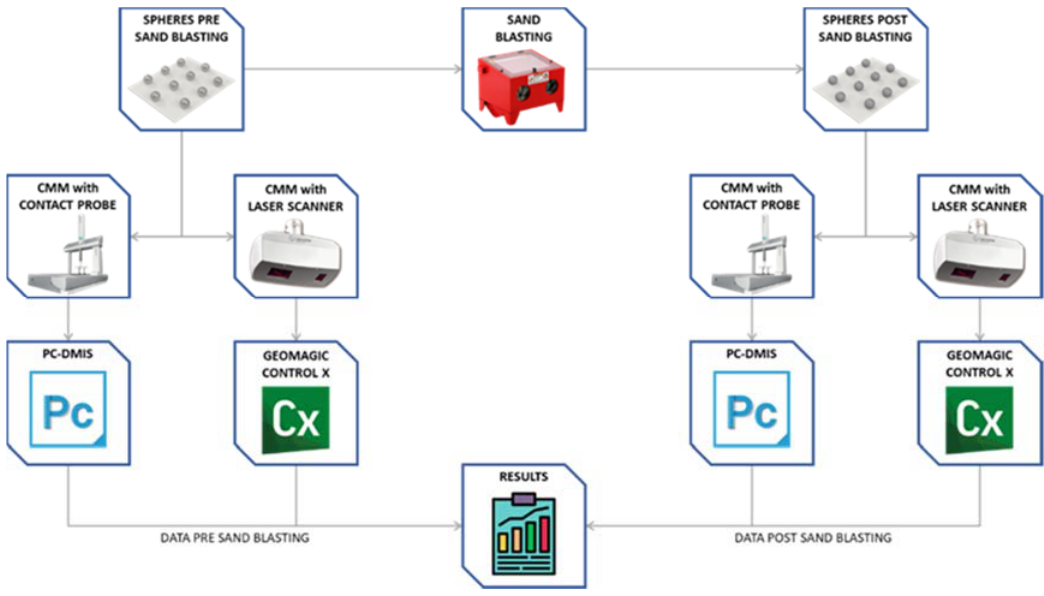
Figure 2. Research methodology.